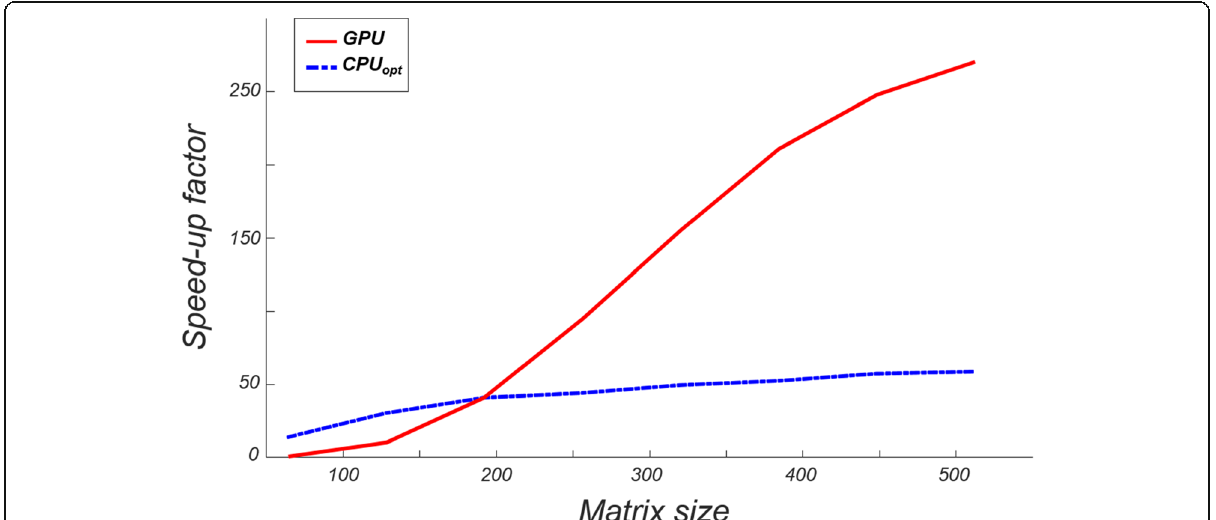
Fig. 2 Comparison of the GPU-based reconstruction time with that of optimized CPU time (CPU opt ). The speed-up factor is CPU opt and the GPU time divided by CPU ref . Note that the performance of the GPU is not substantially better at lower data quantities